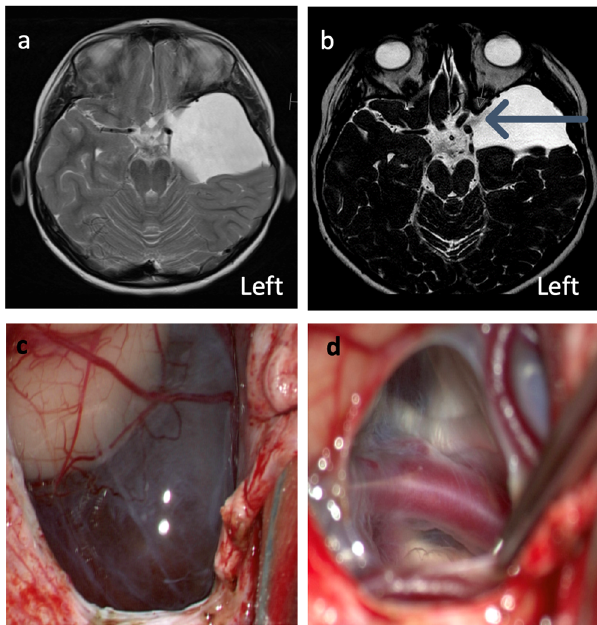
Figure 1. MRI images of left sided temporal AC (patient 1, Table 1) before ( a ) and after ( b ) fenestration. In image b, the fenestration is seen as a flow void (arrow). Image ( c ) displays a cyst after the opening of dura and image ( d ) shows the inner cyst lining above the medial cerebral artery and the cranial nerves.